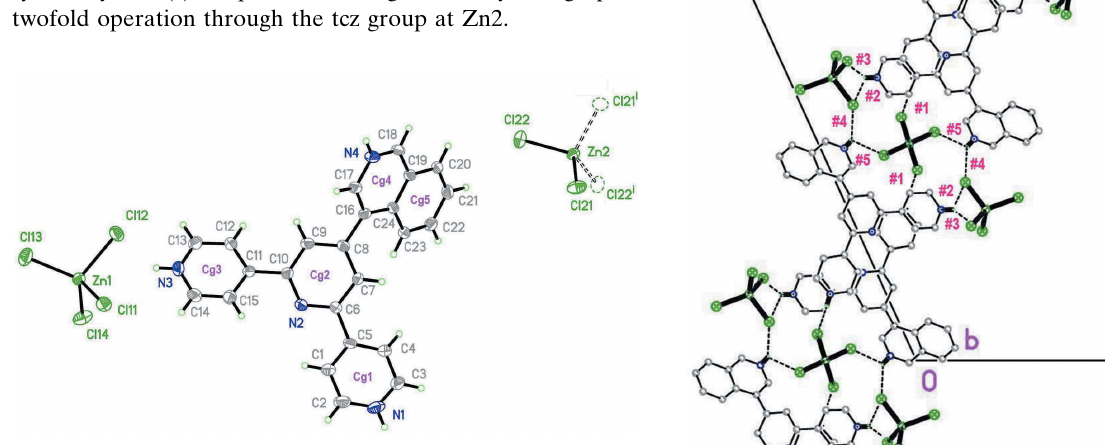
Figure 1 Molecular view of the asymmetric unit in (I), with displacement ellipsoids drawn at the 50% probability level. Atom Zn2 lays onto a twofold symmetry axis. Symmetry code: (i) (cid:3) x + 1, y , (cid:3) z + 3